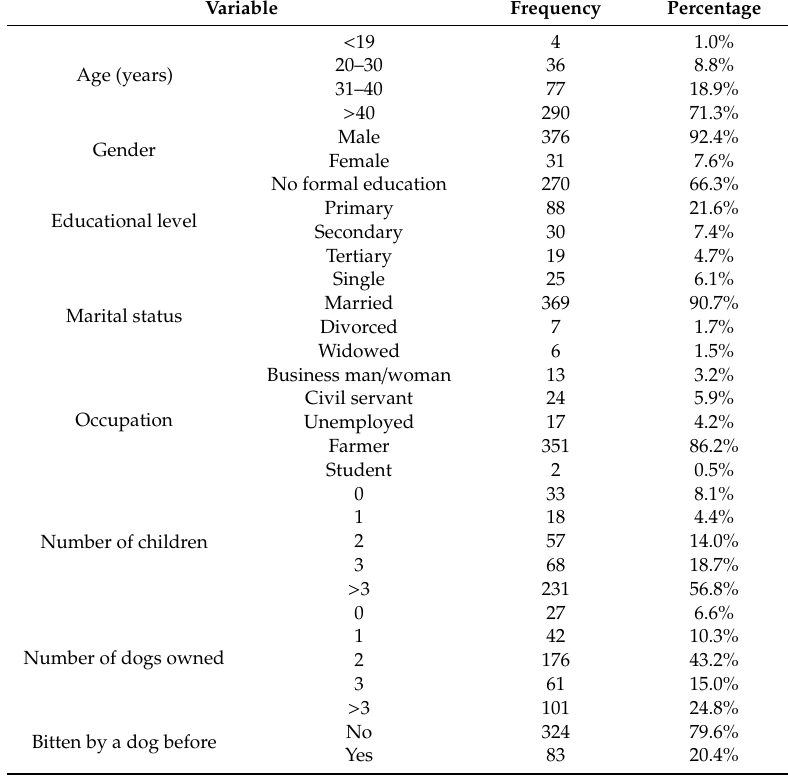
Table 1. Sociodemo graphic characteristics of the population participating in the survey on knowledge, attitudes, and practices of